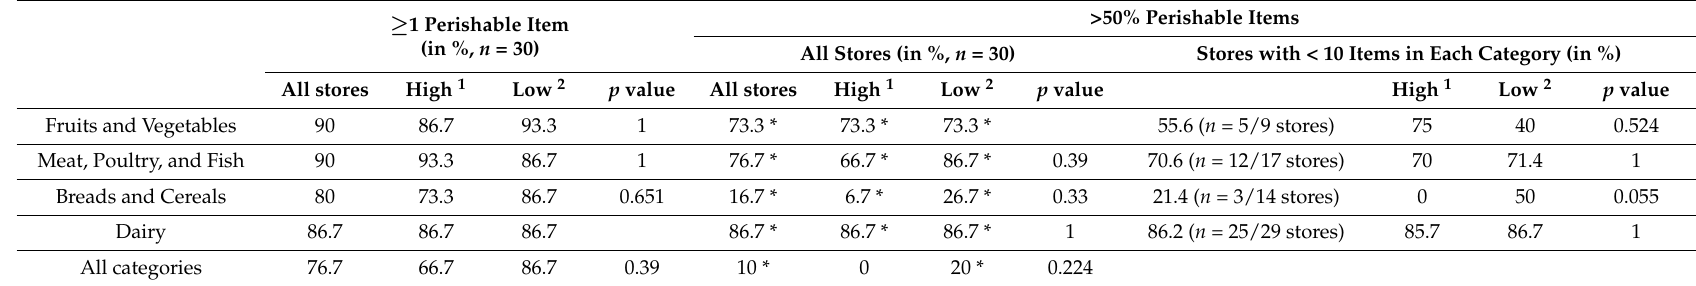
Table 5. Estimate of the proportion of perishable items out of the total items recorded in each category. ≥ 1 Perishable